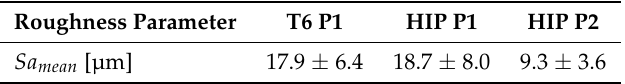
Figure 9. SEM image of the specimen series ( a ) HIP P1 and ( b ) HIP P2. Table 5. Mean value Sa mean of the global Sa values with its 10–90%